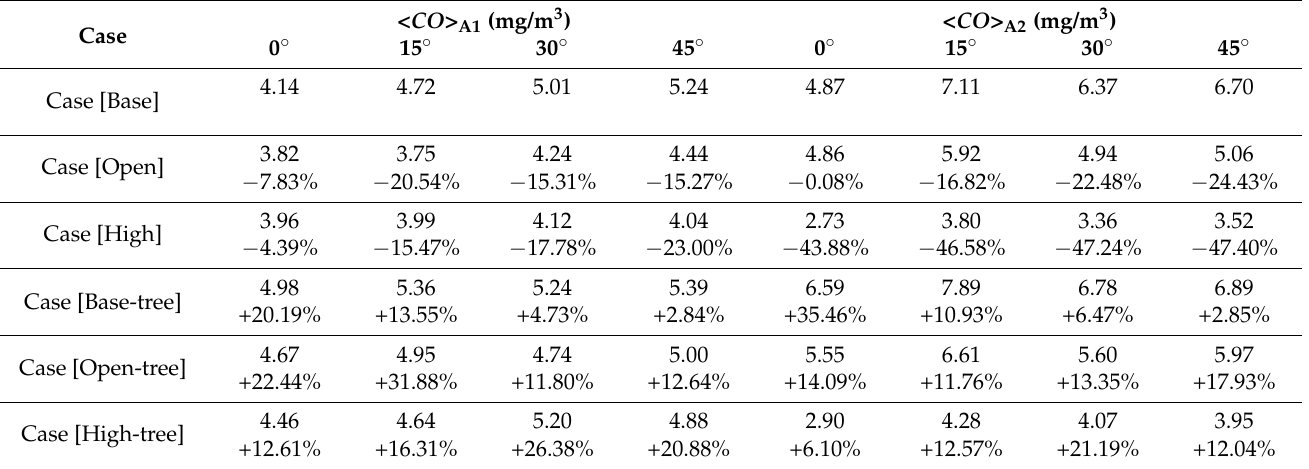
Table A6. Spatial mean CO concentration ( C ) at z = 2 m in Region A1 (< CO > A1 ) and Region A2 (< CO > A2 ) of each scenario and the change rate.